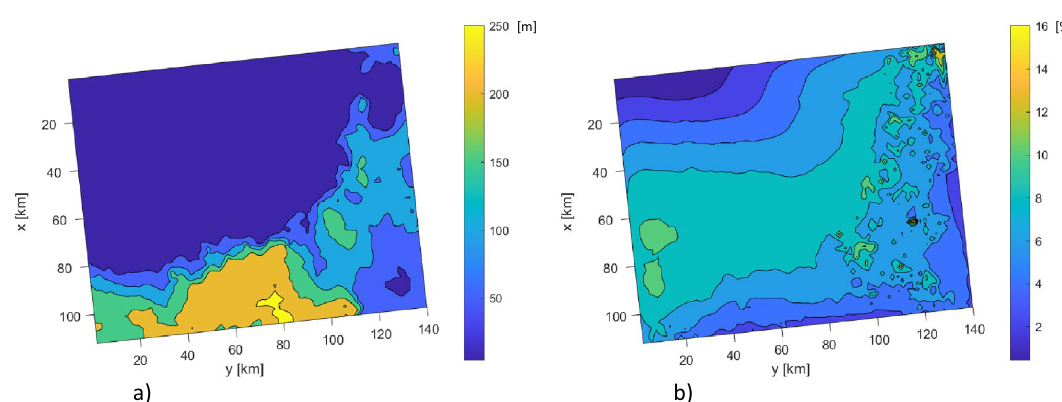
Figure 5. Spatial variability of µ ∗ for parameter #71 at 89 Ma for Z ( a ) and in the age interval 89–66 Ma for V sand ( b with Fig. 5b). In particular, the impact of carbonate production extends to a large portion of the domain when V sand is considered, with an important effect observed in the south-western corner of the domain. The final parameters set p sel selected at this first screening step consists of 97 parameters neglecting 42 parameters out of 139. Figure 6 shows the distribution of the 97 selected parameters (solid bars) over all initial set (transparent bars) expressing different processes contributing to the overall sedimentological output. We observe that parameters associated with supply location and width and carbonate production are all considered important. On the other hand, slope failure parameters are always negligible, thus indicating such process is not contributing significantly to the selected outputs. Information like the one gathered here can assist modellers in identifying which processes and parameters are worth further investigation (for example through dedicated analyses of literature and proprietary data) and which can be conversely neglected. Following the procedure outlined in Section "Range analysis" we analyse the investigated parameters intervals. Figure 7 exemplifies two results of this procedure. Each bar in the plot represents the probability F n ( i , l ) to find a realization in the set S n at the considered level where n = 5 . Red crossed lines indicate the preliminary intervals while the green crossed lines correspond to the new intervals bounds. In Fig. 7a we observe that the distribution of parameter #71 ( F n ( i = 71, l ) , associated with maximum carbonate mud production at 90 Ma [m/My] is con- centrated close to the right boundary. Hence, the parameter range is enlarged from the interval [5, 25] to [5, 35]. Figure 7b depicts the distribution F n ( i = 107, l ) , for parameter #107 which is slope driven marine silt transport coefficient [km 2 /Ky]. The total frequency F n is 2% in the two levels associated with the top 25% of the interval (corresponding with the last two levels). As a result, the procedure proposes a reduction of the upper bound of the interval from 1 to 0.75. It is important to note that range modification should be performed according to the physical and geological meaning of the parameters, therefore parameter modifications are finalized only after human intervention, i.e., after checking that the new proposed boundaries are not exceeding physical or geological meaning associated with given quantities (e.g., transport coefficients cannot assume negative values).